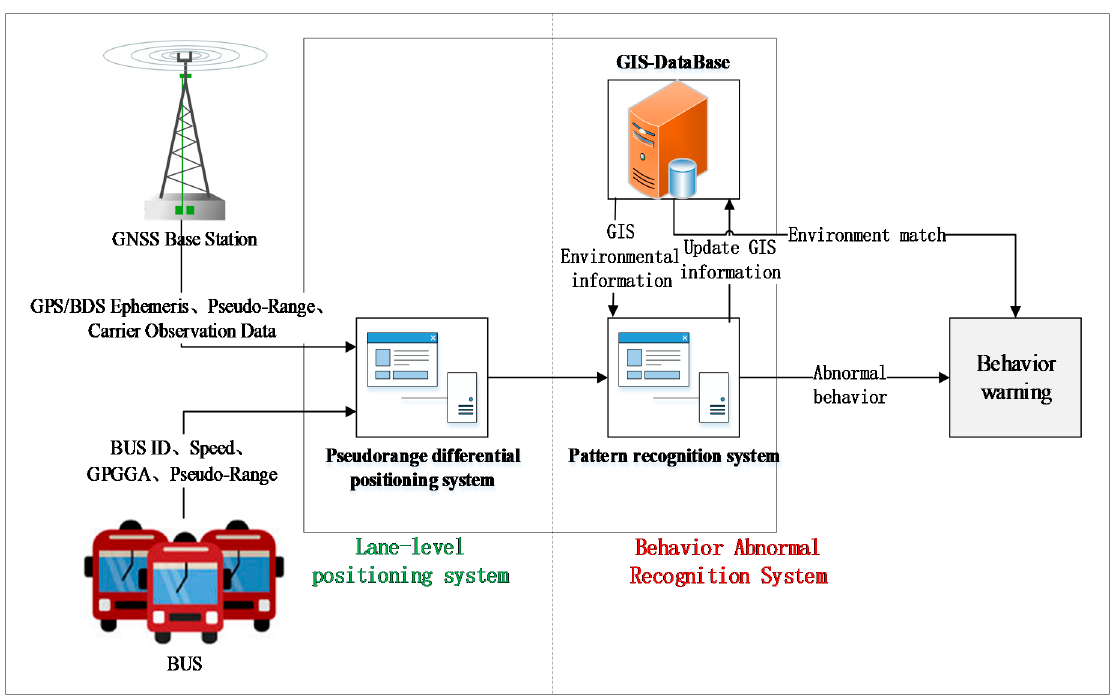
Figure 1. System structure of the proposed bus tracking and behavior analysis method.